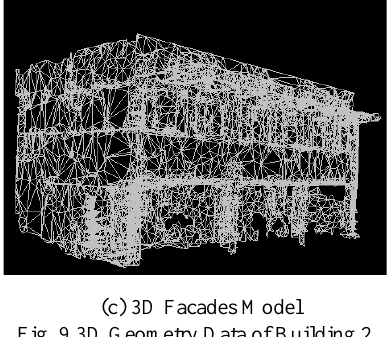
Fig. 9 3D Geometry Data of Building